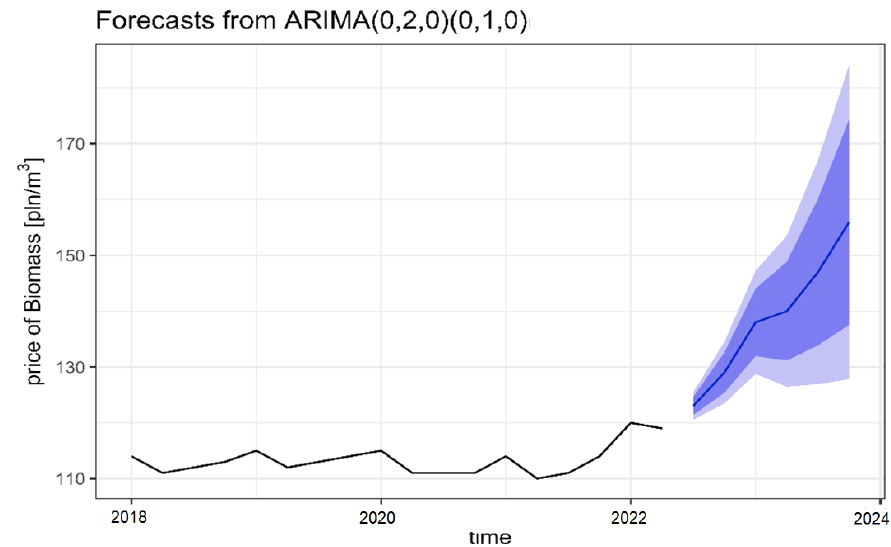
Figure 9. Price forecast for the S4 assortment in Q3 of 2022, Q4 of 2022, and Q1 of 2023. Source: Own elaboration based on data obtained from the State Forests IT System (SILP) [4].